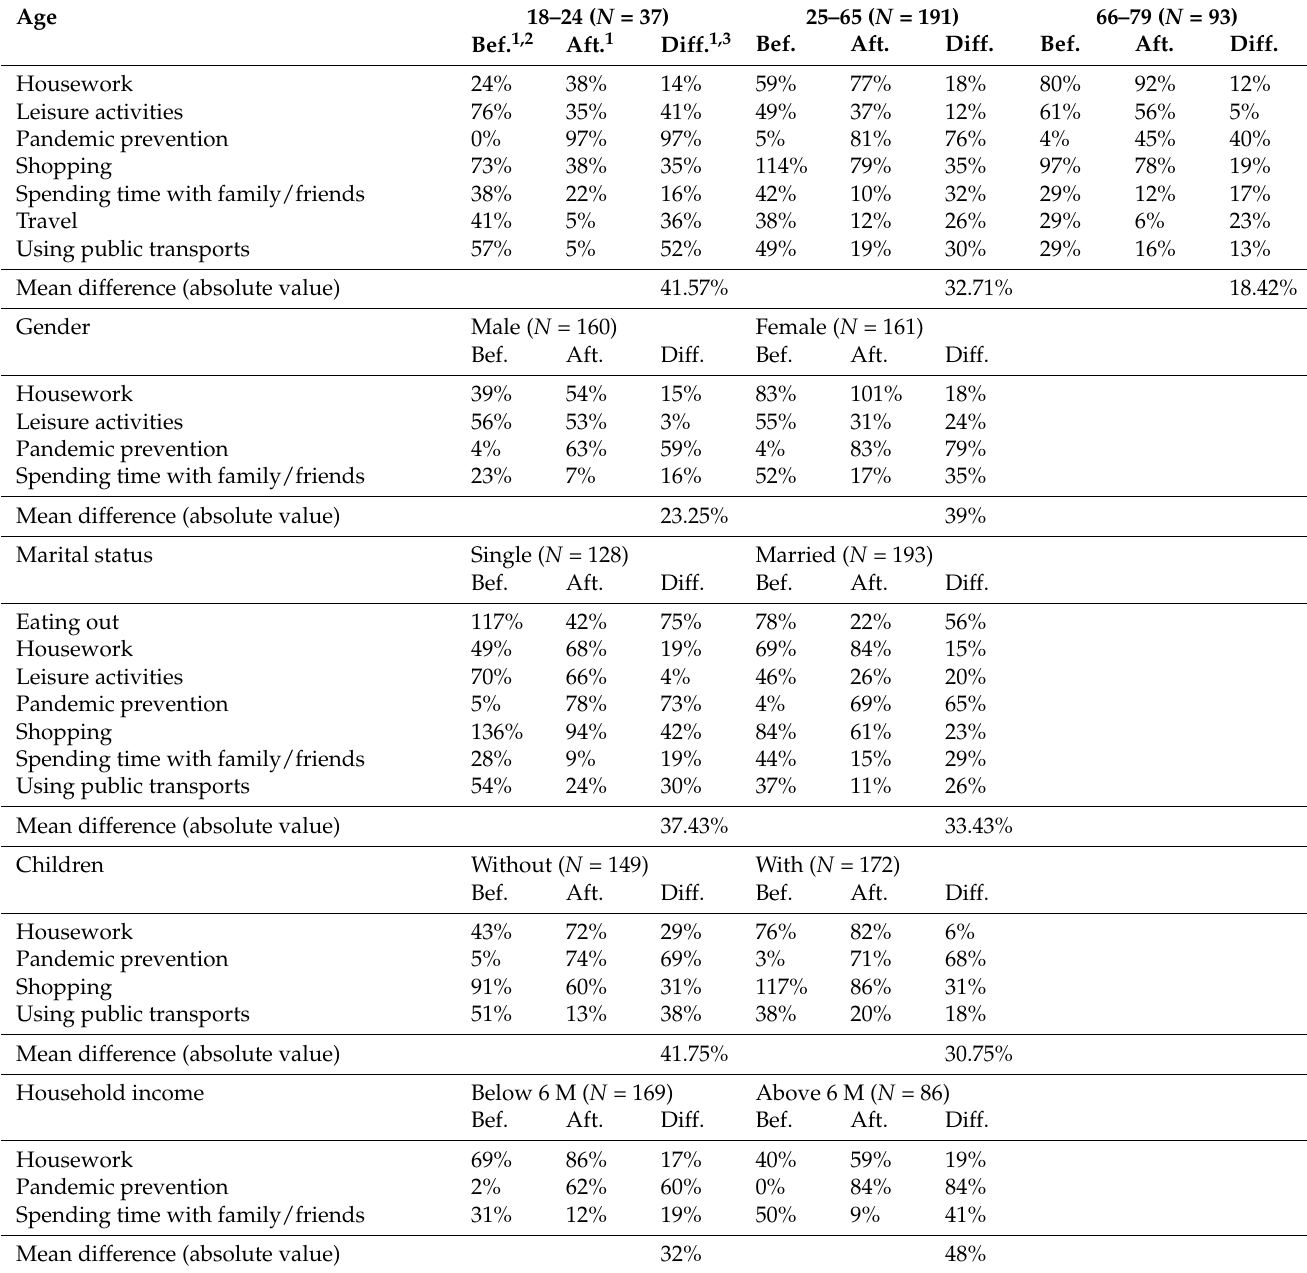
Table 3. Appearance rates for the selected behaviors by